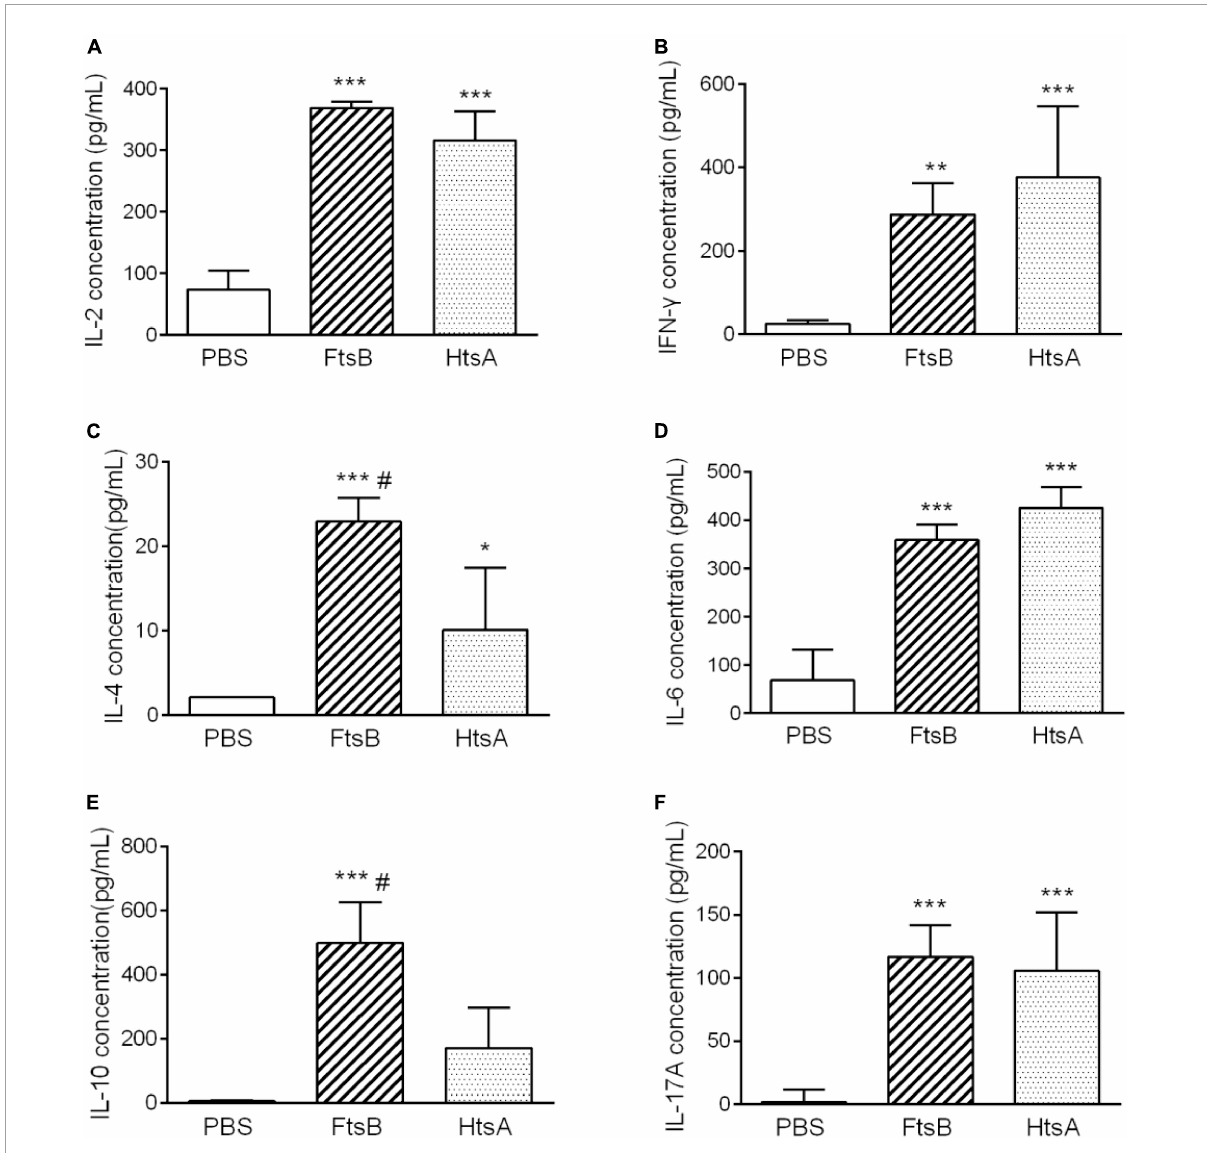
FIGURE7 Immunization with FtsB stimulated the secretion of the cytokines IL-2, IFN- γ , IL-4, IL-6, IL-10 and IL-17A. (A) The secretion of the cytokine IL-2. (B) The secretion of the cytokine IFN- γ . (C) The secretion of the cytokine IL-4. (D) The secretion of the cytokine IL-6. (E) The secretion of cytokine IL-10. (F) The secretion of the cytokine IL-17A. n = 5 mice per group, * p < 0.05, ** p < 0.01, *** p < 0.001 vs. PBS control group, # represents p < 0.05 vs. HtsA group. The HtsA protein plus an aluminum adjuvant was used as a positive control, and PBS plus an aluminum adjuvant was used as a negative